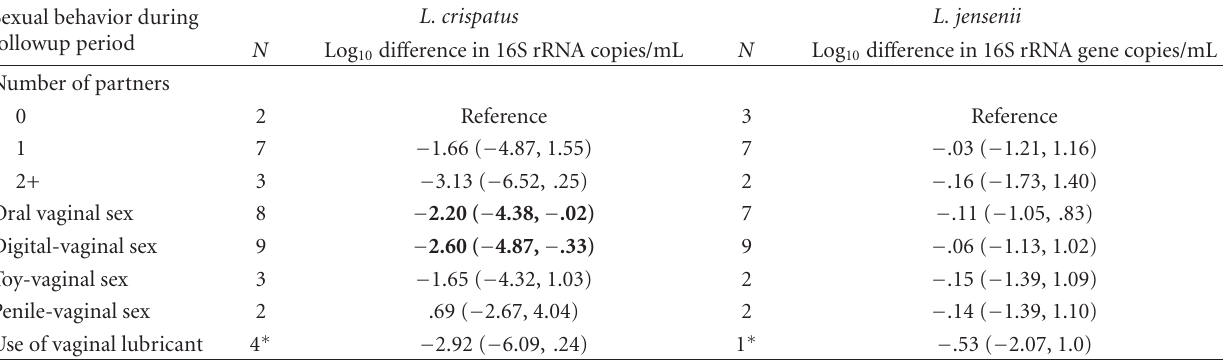
Table 2: Association between reported sexual behaviors during treatment and followup and quantity of L. crispatus or L. jensenii in women who were colonized at the posttreatment